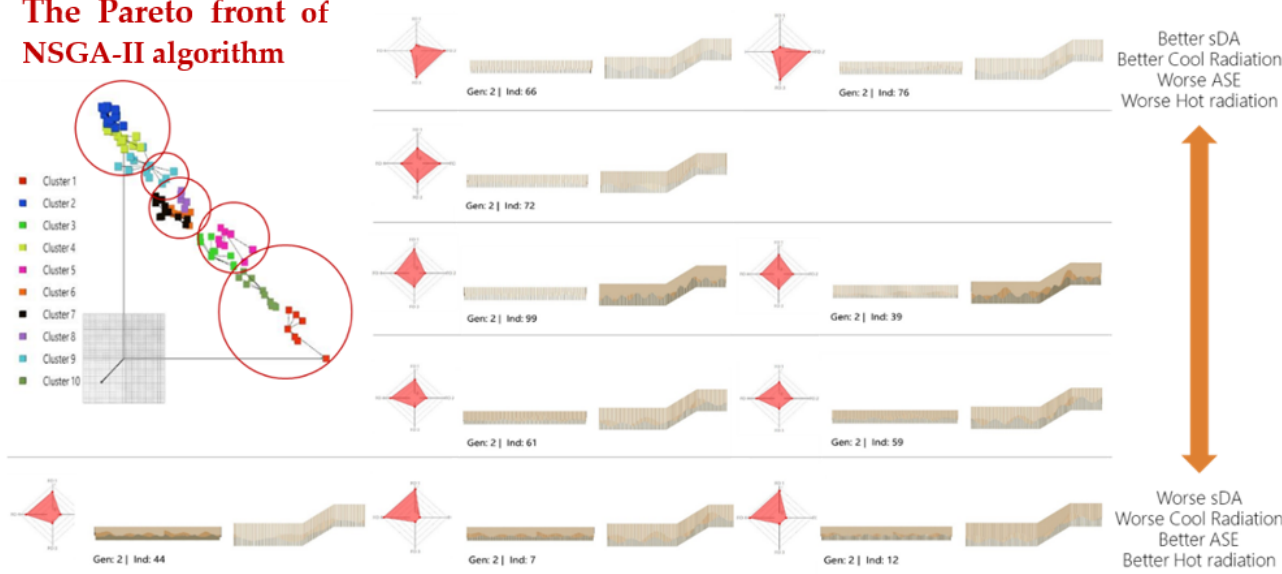
Figure 5. The comparison of different optimal solutions on radiation performance.